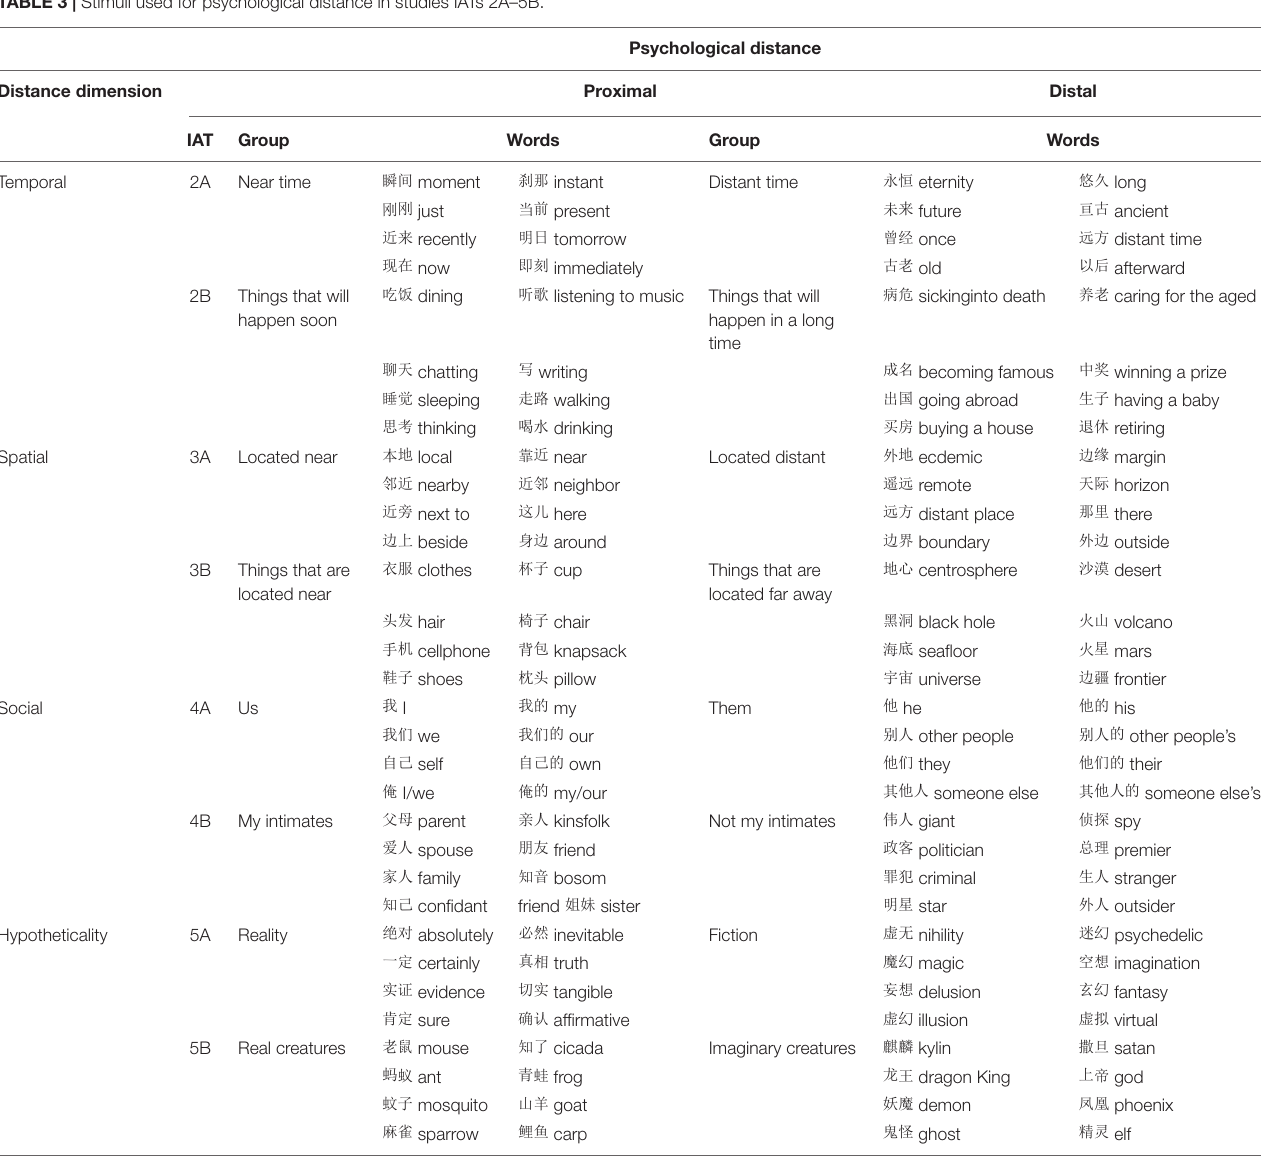
TABLE 3 | Stimuli used for psychological distance in studies IATs